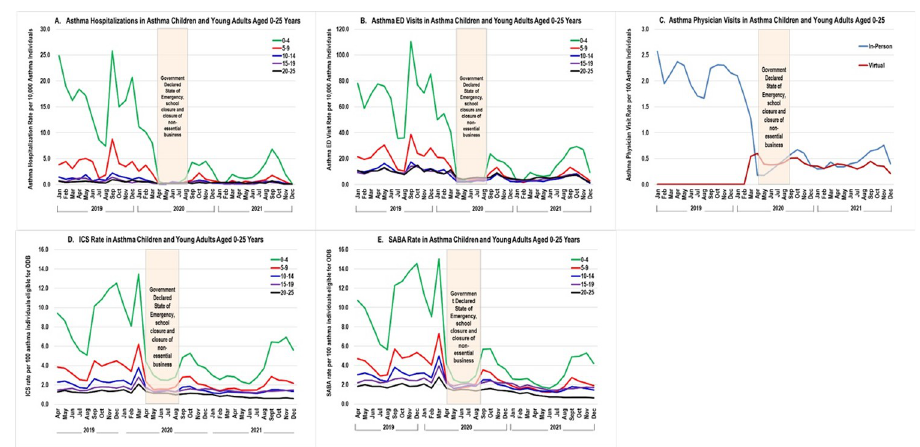
Fig 1. Asthma health services use rates by age groups, January or April 2019 to December 2021 (N = 716,690). Abbreviations: ICS = inhaled corticosteroid; SABA = short-acting beta 2-agonist; ODB = Ontario Drug Benefit.